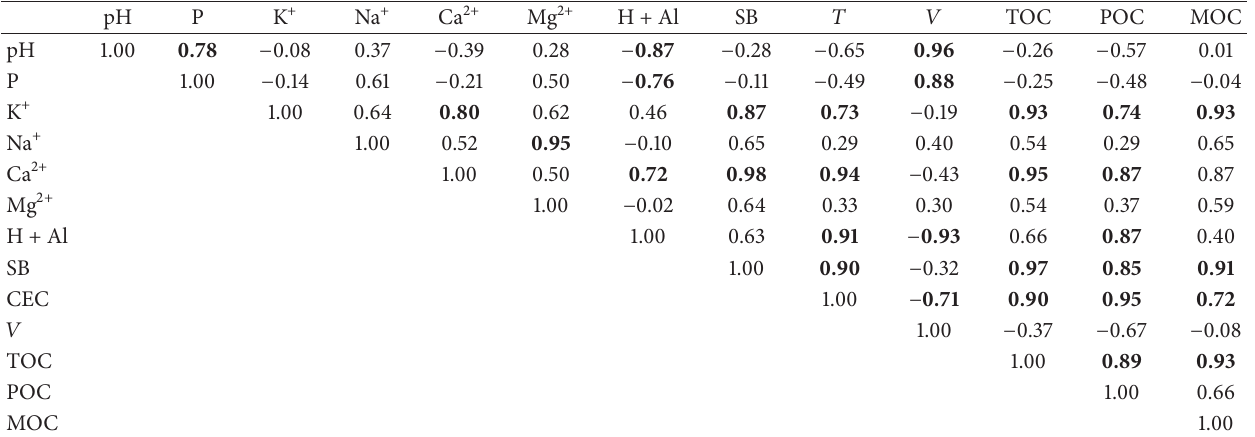
Table 6: Coefficients of correlation of Pearson between the variables evaluated in the present